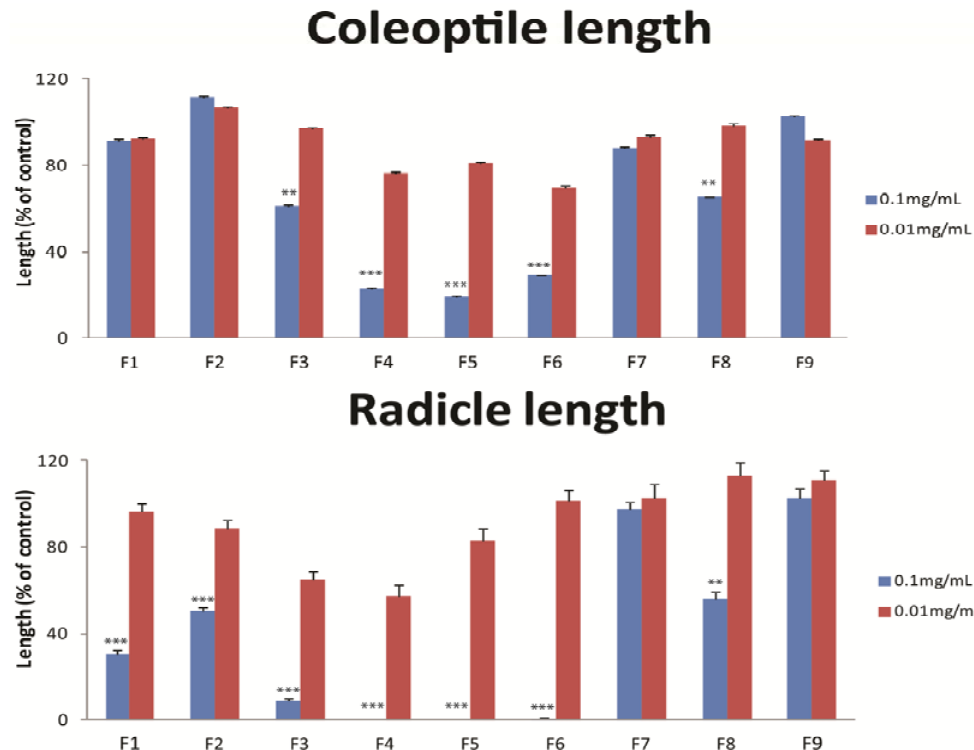
Figure 4. The effect on nine sub-fractions of a butanol fraction, derived from a methanol extract of Amaryllis belladonna , on coleoptile and radicle length of Senecio vulgaris seeds at concentrations of 0.1 and 0.01 mg/mL. Effects are expressed as coleoptile or radicle length of the treatment as a percentage of the corresponding length of coleoptile or radicle length of the control. Data present means and standard deviations of three replicates. Significant differences between control and treatment are indicated as ** p ≤ 0.01 and *** p ≤